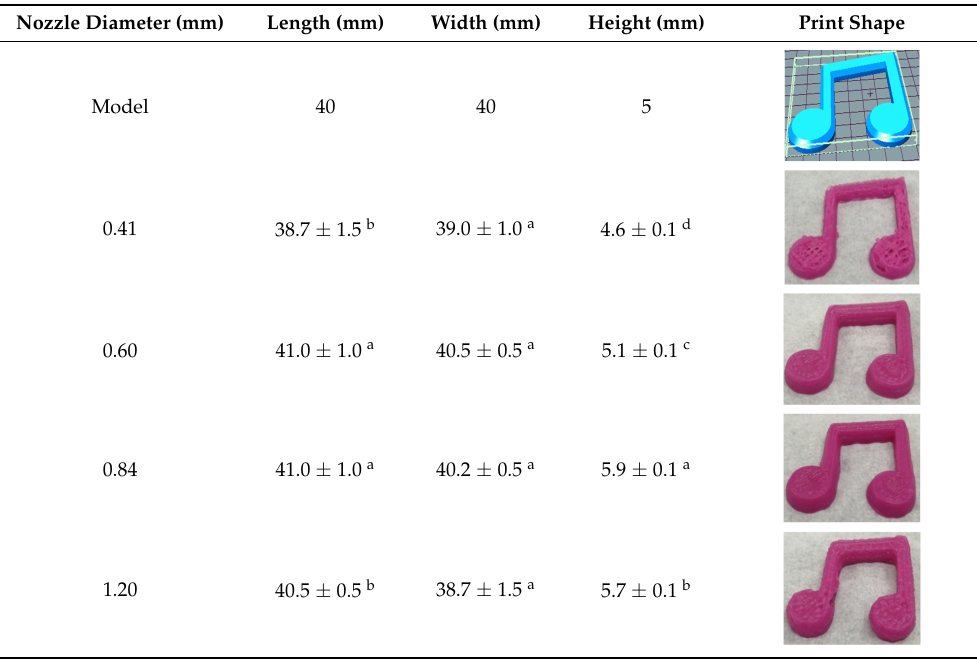
Table 2. Effect of nozzle diameter on 3D printing of AS